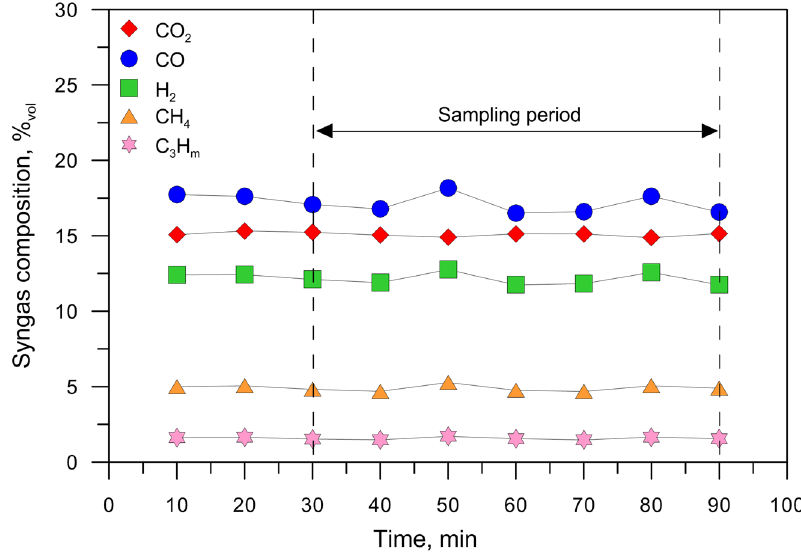
Figure 2. Producer gas composition profile obtained during wood gasification test.